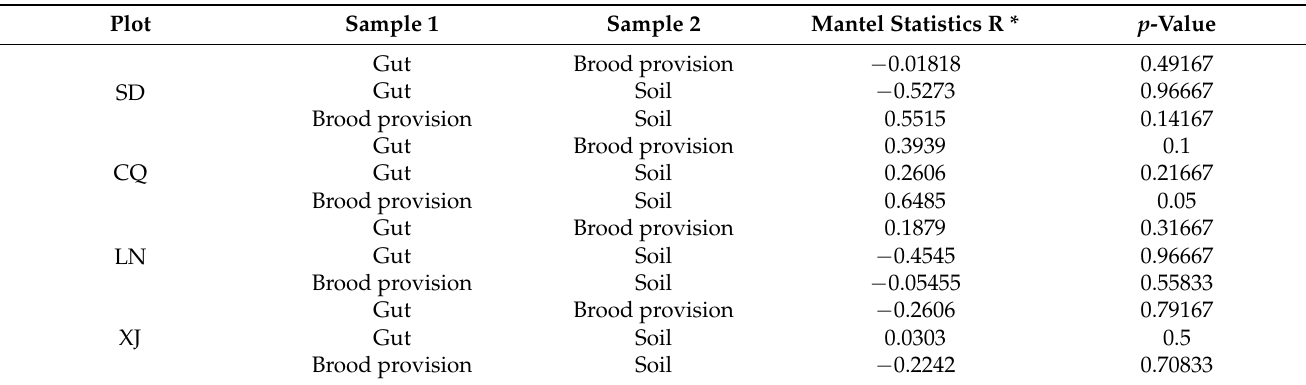
Table 3. Mantel correlations among Bray–Curtis distance matrices based on bacterial OTUs in gut, brood provision, and nest soil.